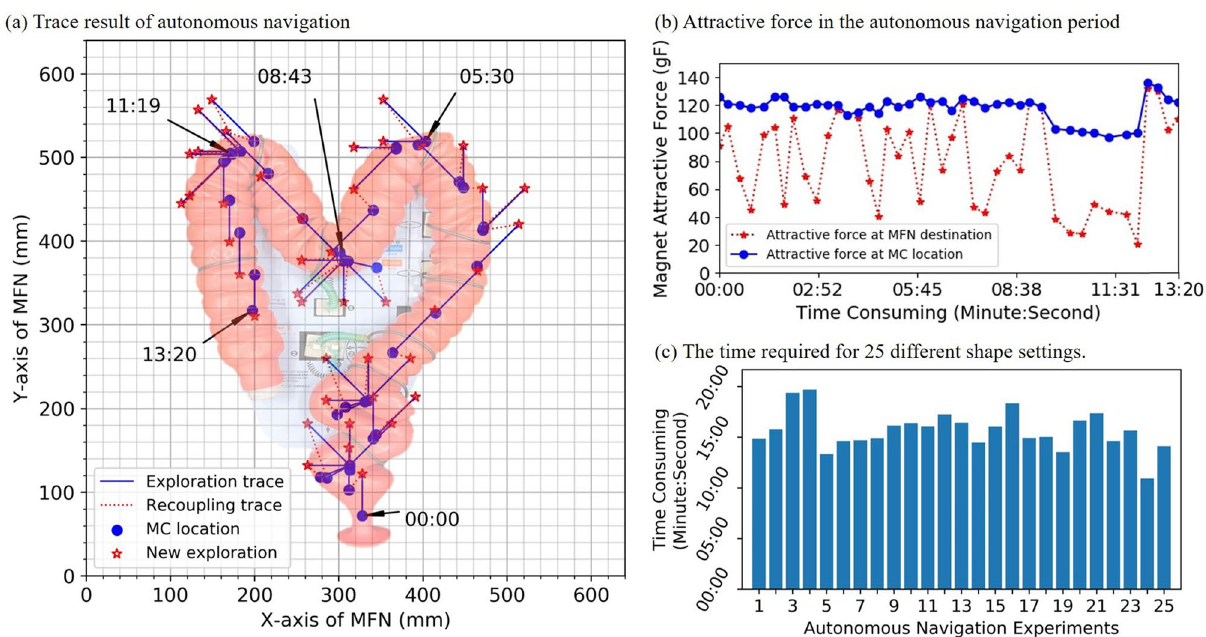
Figure 5. The tracking result of autonomous navigation. ( a ) Illustration of the autonomous navigation trajectory. ( b ) Attractive force in each state corresponds to the tracking result in the graph ( a ). ( c ) Time required to complete autonomous navigation experiment 25 times. The average navigation duration was 15 min 38 s, corresponding to an average moving speed of 96